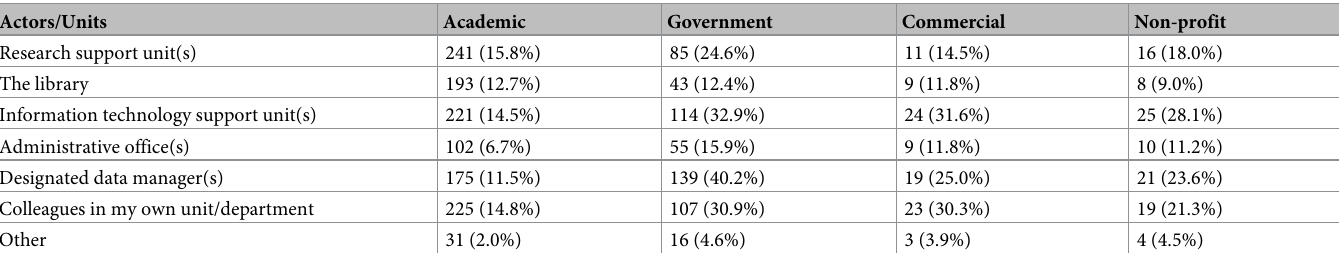
Table 12. Crosstab between a primary sector and "which of the following are involved in data management/storage in your organization?”.